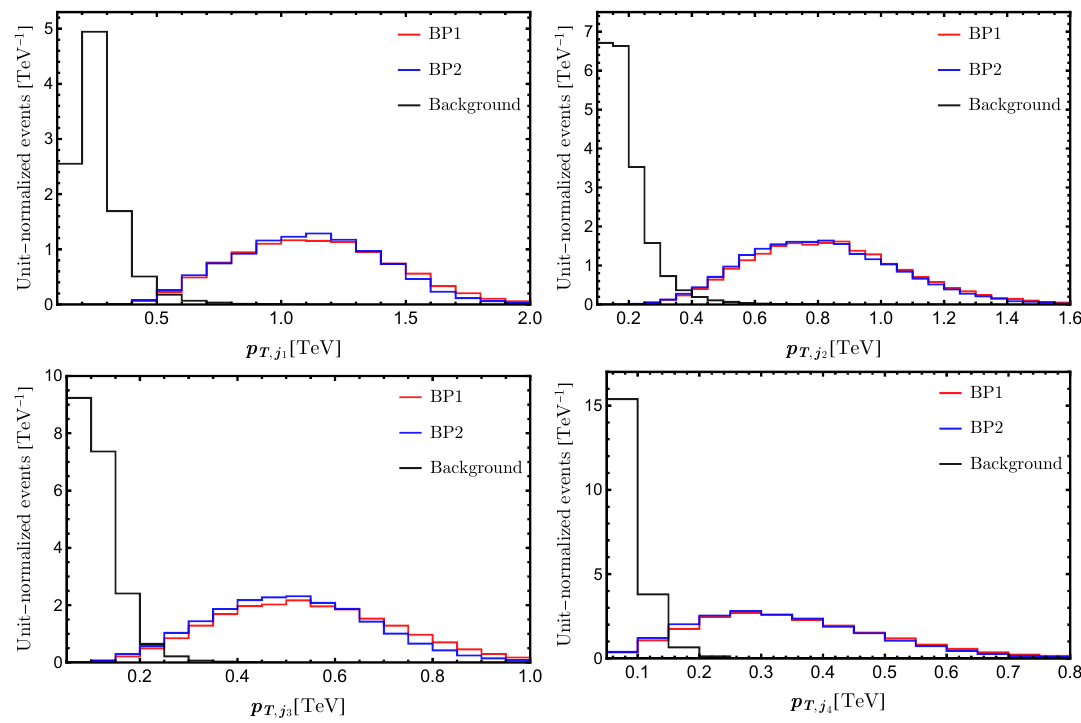
Figure 9 . Distributions of ordered transverse momenta, p T,j II and the QCD 4-jet background